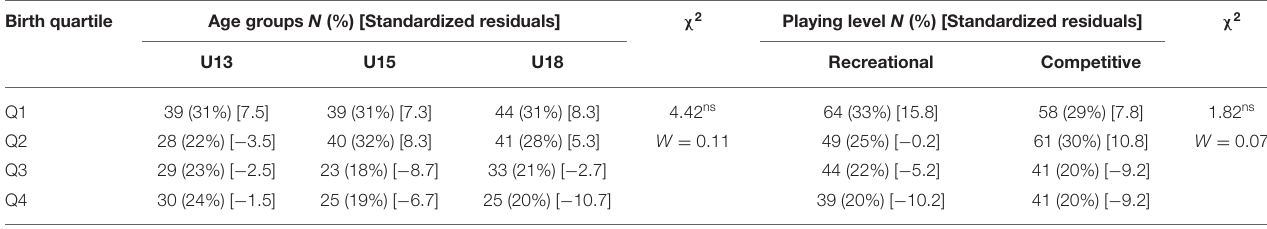
TABLE 2 | RAE prevalence across age groups and playing levels.